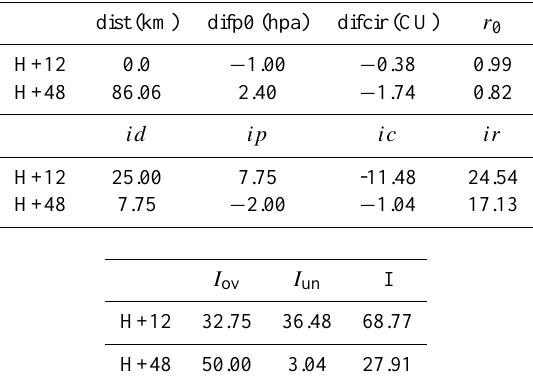
Table 3. Differences and index values for two different forecasts (H+12 and H+48) of the cyclone which affected the Balearic Islands on 4 May 2010 at